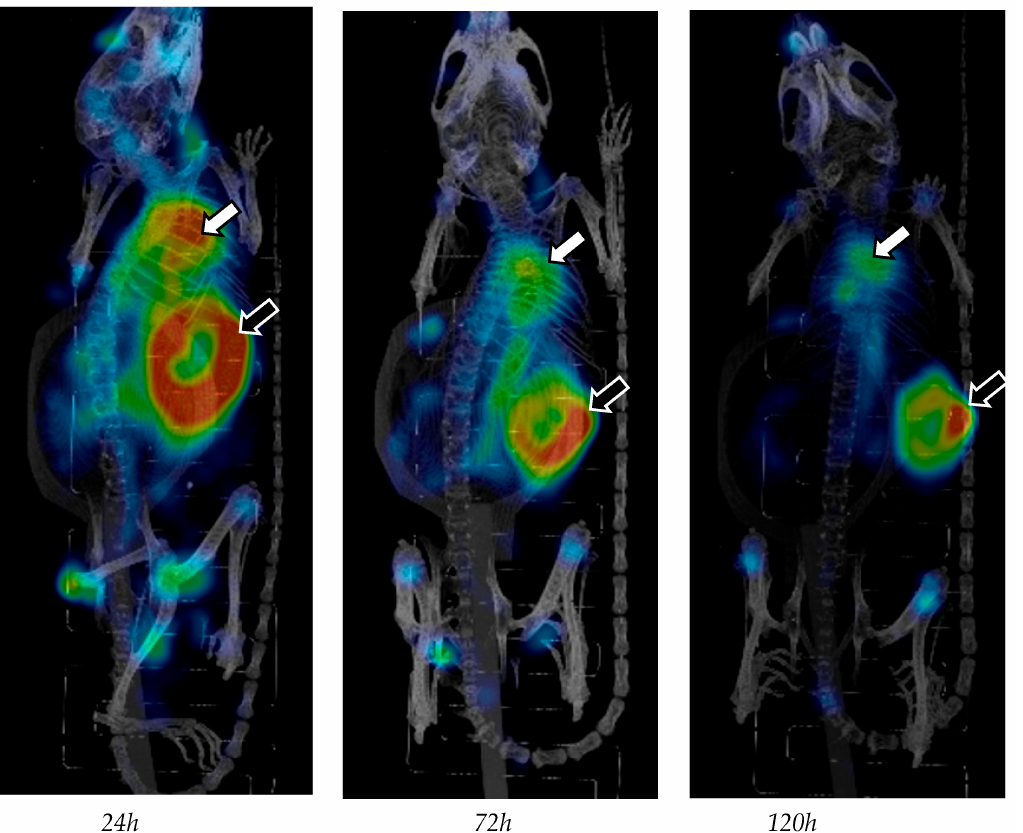
Figure 1. Reconstructed 3D body scans were visualized using maximum intensity projection at 24, 72 and 120 h, and the SPECT scale was adjusted by cutting 10% of the lower signal intensity to make the high-intensity regions readily visible. The white arrow points to the heart and the black arrow points to the infected implant. An increased signal is seen at the hips and knees probably due to detached 111